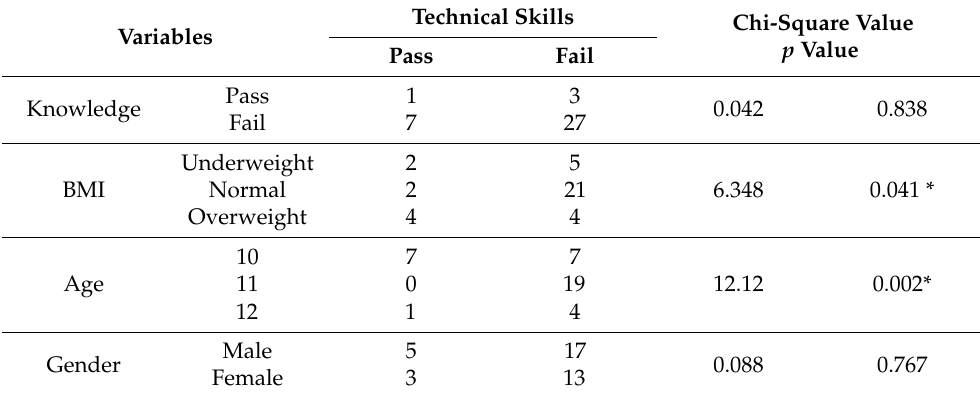
Table 4. Association between knowledge, BMI, age, and gender with respect to technical skills following the course.